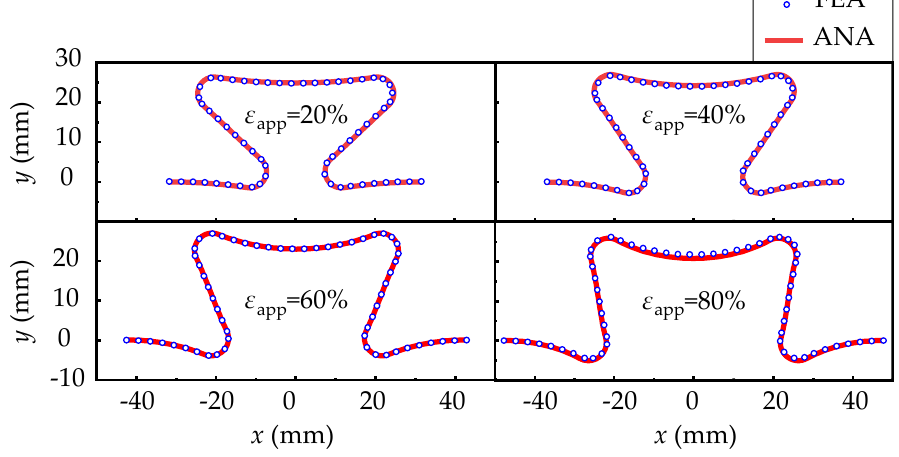
Figure 3. The deformations between FEA and analytic results when applied strains are 20%, 40%, 60% and 80%, respectively.